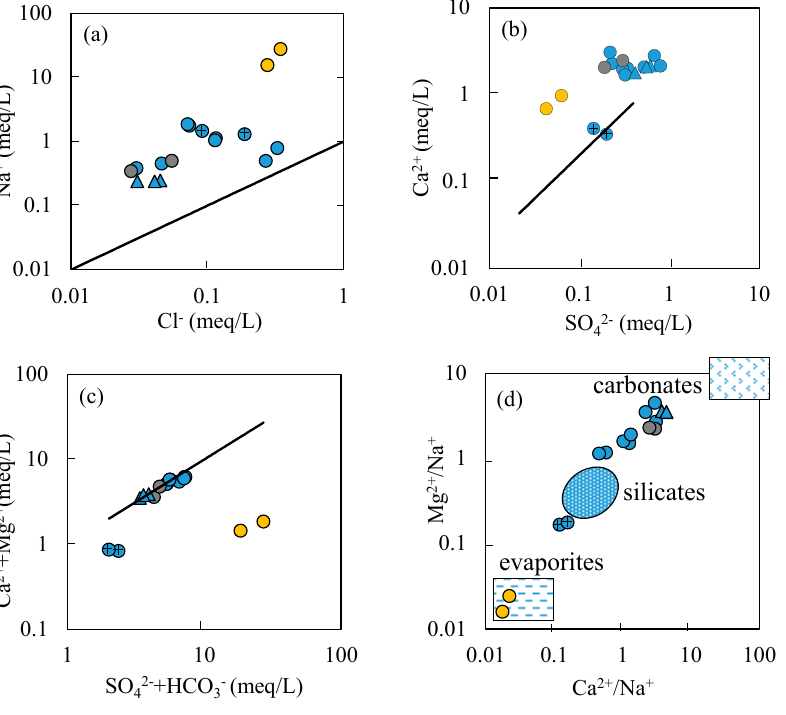
Figure 6. Relationship between ( a ) Na + and Cl − , ( b ) SO 42 − and Ca 2 + , ( c ) [Ca 2 + + Mg 2 + ] and [SO 42 − + HCO 3 − ], and ( d ) [Ca 2 + / Na + ] and [Mg 2 + / Na + ]. Triangles are river samples, circles are groundwater samples, and circles with a cross are the water samples at the borehole ZK. Yellow represents the spring at Zhanggu, grey represents the spring at Kemu, and blue represents the rest.